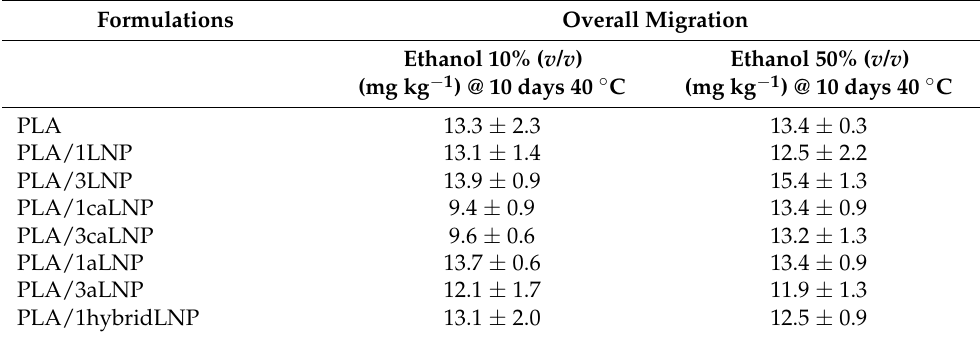
Table 4. Overall migration values in Simulants A and D1 (10% ( v / v ) and 50% ( v / v ) ethanol, respec- tively) for PLA and PLA nanocomposite